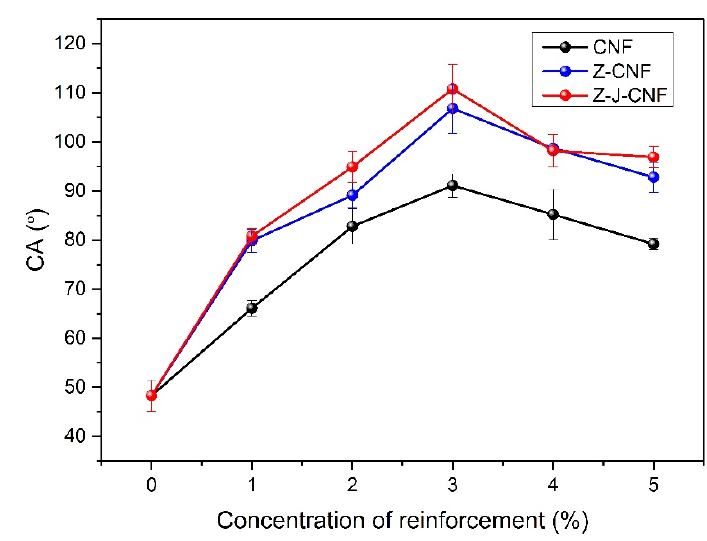
Figure 12. Effects of CNF, Z-CNF, and Z-J-CNF content on the contact angle of the films. Nanomaterials 2020 , 10 , x FOR PEER REVIEW